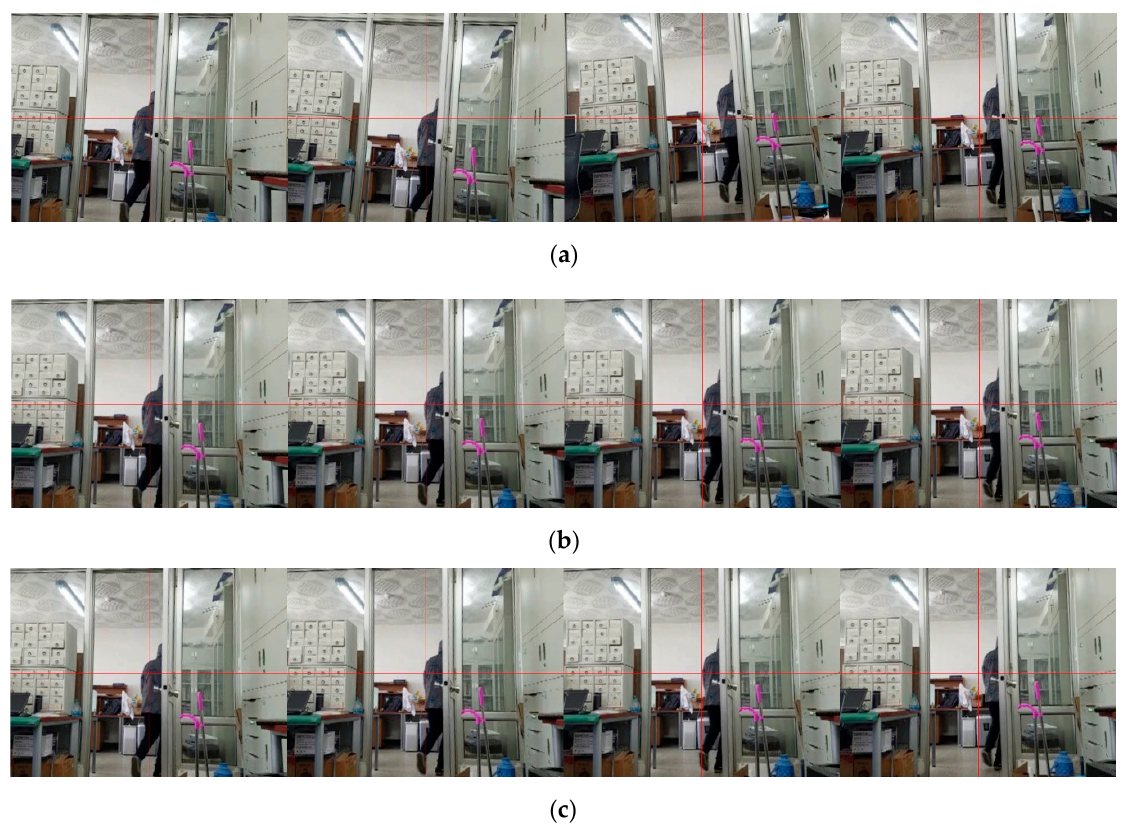
Figure 4. Stabilized image sequences. ( a ) Image sequence before stabilization; ( b ) Stabilized by optical flow; ( c ) Stabilized by image matching with FREAK (Fast Retina Keypoint) descriptor.